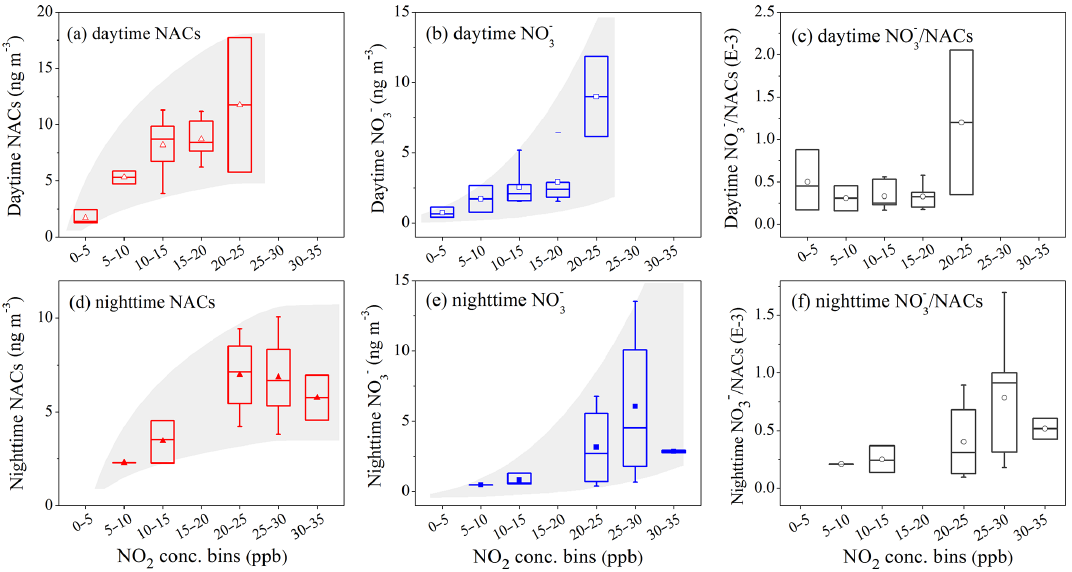
/ NAC ratios as a function of NO 2 concentration bins during daytime and nighttime. The Figure 5. Concentration of NACs, nitrate and NO − 3 markers represent the mean values and whiskers represent the 25th and 75th